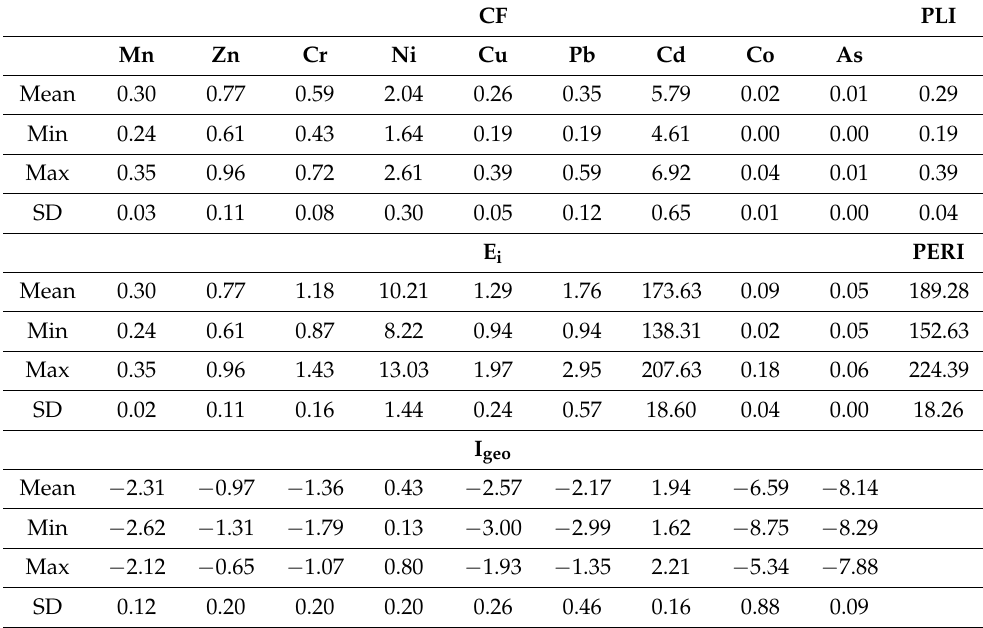
Figure 6. Contribution of heavy metals to the Ei in soil samples, Liwa, UAE. Table 4. Basic statistics of the contamination factor (CF), pollution load index (PLI), single ecological risk index (E i ), and PERI for heavy metals in the soils from Liwa, Abu Dhabi. CF